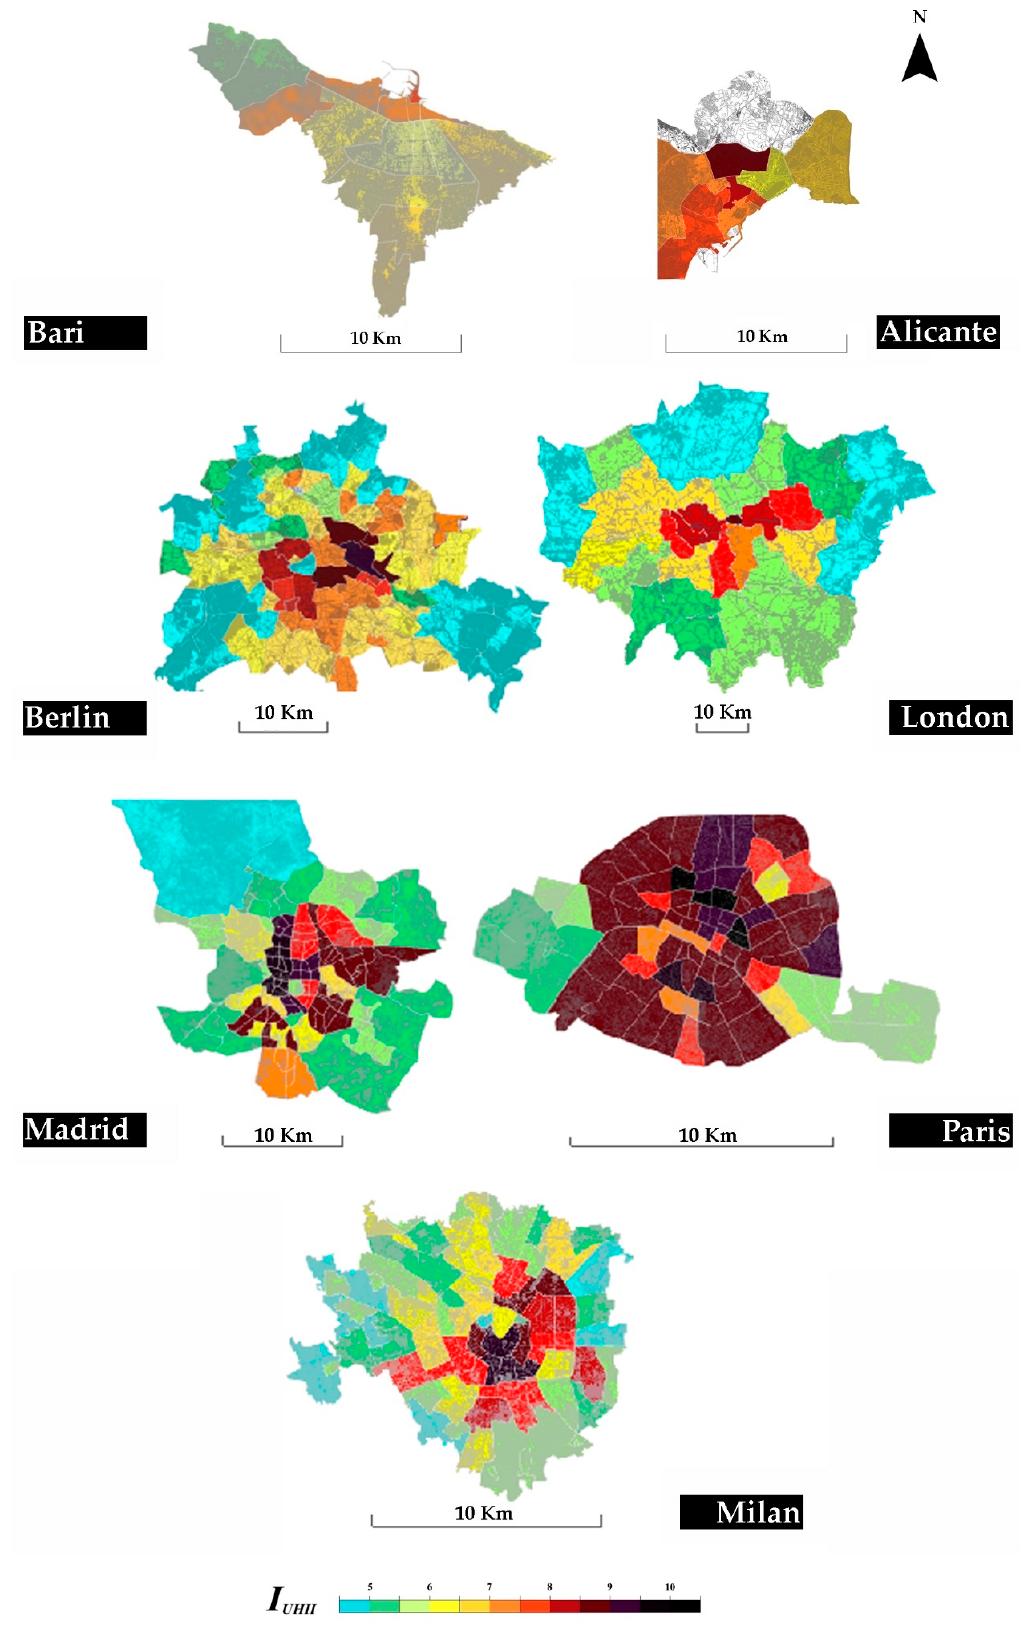
Figure 5. Evaluation of 𝐼 (cid:3022)(cid:3009)(cid:3010)(cid:3010) to 7 European cities with a total of 344 urban districts.